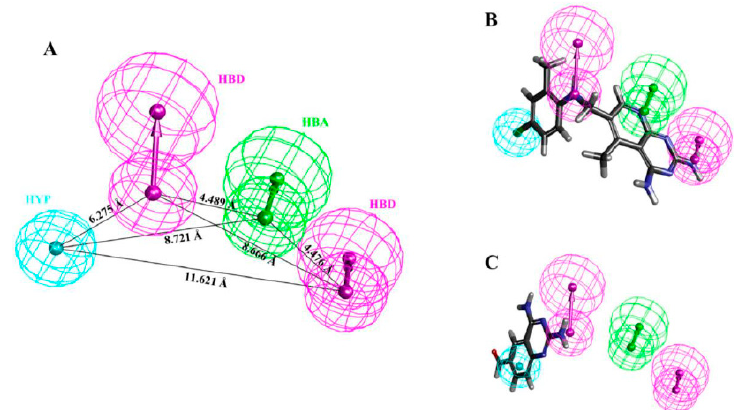
Figure 2. ( A ) Shows the 3D spatial arrangement and distance constraints of the chemical features of Hypo1. Hypo1 consists of one hydrogen bond acceptor (green), two hydrogen bond donor (magenta), and one hydrophobic (cyan) features. ( B ) Alignment of the reference compound (the most active compound of the training set (IC 50 = 0.19 nM/L)) mapped all the features of the Hypo1. ( C ) Alignment of the least active compound of the training set (IC 50 = 10,000 nM/L) mapped the hydrogen bond donor features only and missed the hydrogen bond acceptor and hydrophobic features of the